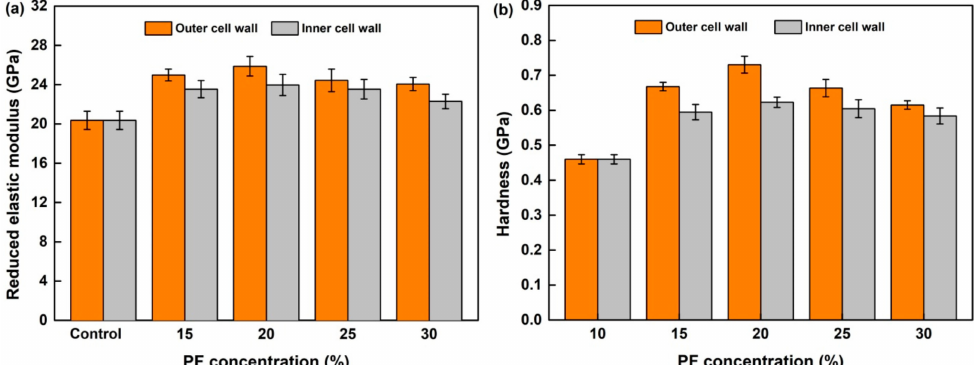
Figure 8. Mechanical properties for the control and PF-modified wood cell walls. ( a ) Reduced elastic modulus and ( b ) hardness.